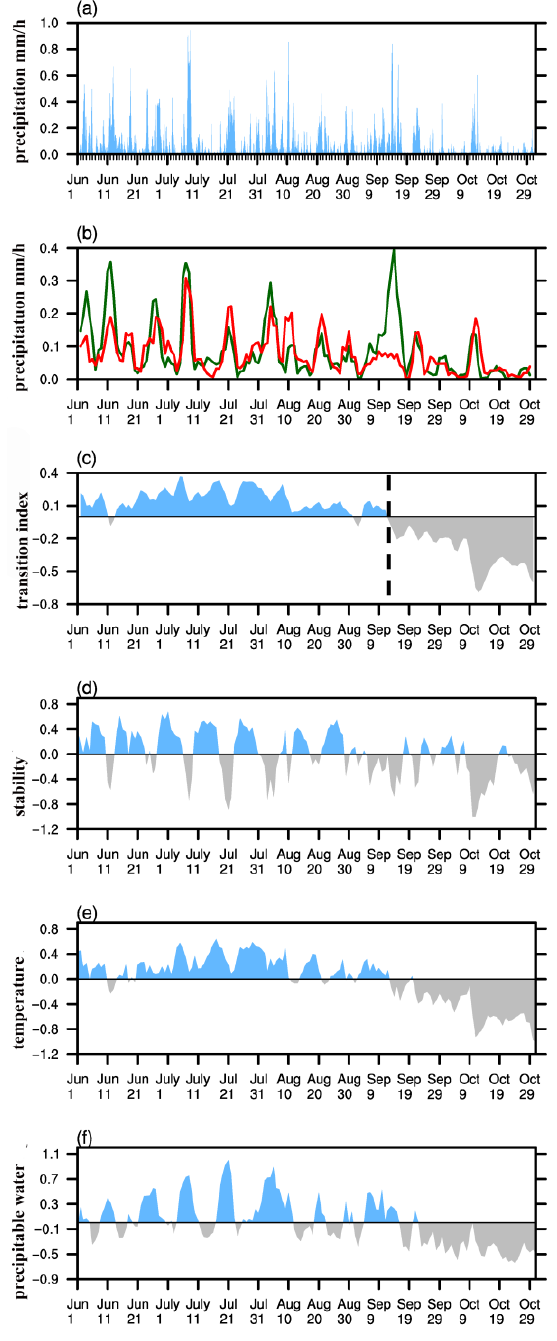
Figure A6. For June–October 2014, ( a ) hourly domain (white box in Figure 1a) averaged precipitation; ( b ) 3-day running mean of nighttime (20:00–08:00, dark green line) and daytime (08:00–20:00, red line) rainfall; ( c ) 3-day running mean of transition index anomaly (TI); normalized domain averaged ( d ) atmospheric stability anomaly, ( e ) 2 m temperature anomaly, and ( f ) precipitable water anomaly. The black dashed line in ( c ) indicates transition date 12 September 2014.